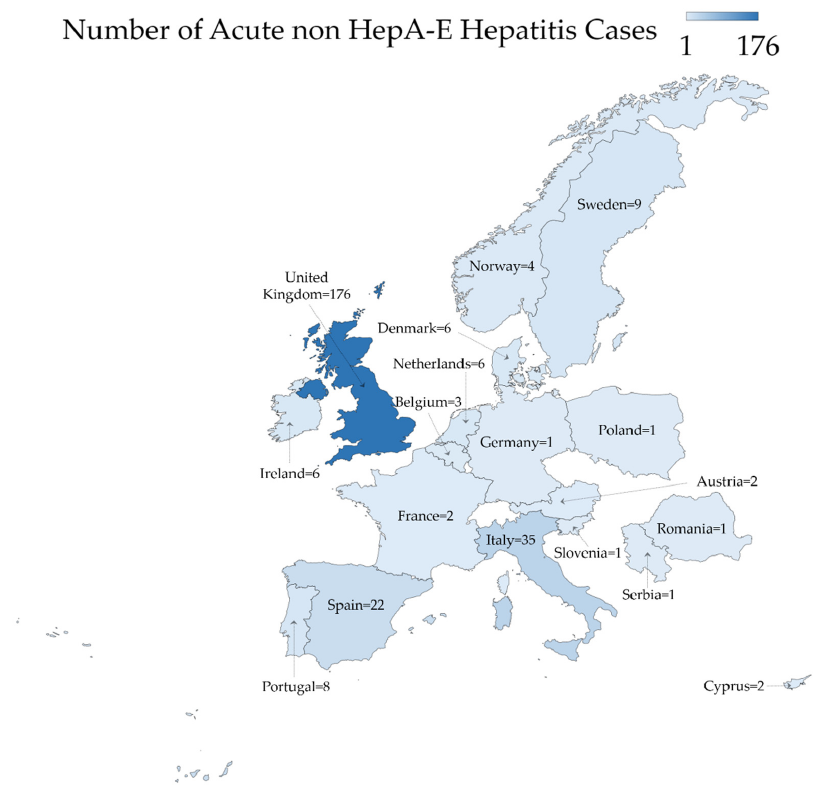
Figure 3. The geographic distribution of acute non HepA ‐ E hepatitis in Europe as of 13 May 2022. The map was generated in Microsoft Excel, powered by Bing, © GeoNames, Microsoft, Navinfo, TomTom, Wikipedia. We are neutral with regard to jurisdictional claims in this map.